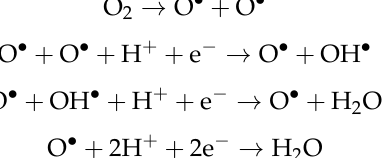
Figure 5. Performance of FePt/VC and Pt/VC in a self-breathing PEMFC, ( a ) current density vs. volt- age, ( b ) current density vs. power density, catalyst loading at the active area of both the anode and cathode was the same, i.e., 0.8 mg cm − 2 . The H 2 flow rate was 10 mL min − 1 . Catalyst loading was the same at both MEAs (0.8 mg cm − 2 ) and the self-breathing PEMFC operation was done at an ambient condition (25 °C, H 2 at 1 bar and 20%RH at the anode). The performance of FePt/VC was further evaluated through an accelerated stress test under self-breathing PEMFC operation. Figure 6 shows the evolution of the polarization curves up to 60,000 cycles, with a degradation in fuel cell performance of 4% only (at 200